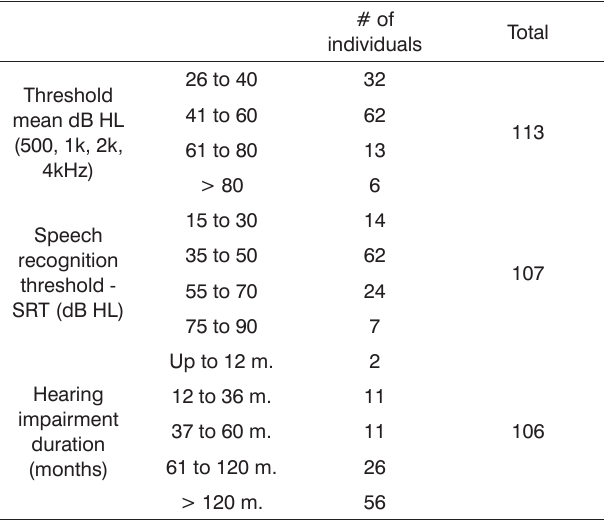
Table 1. Data on the participants’ hearing